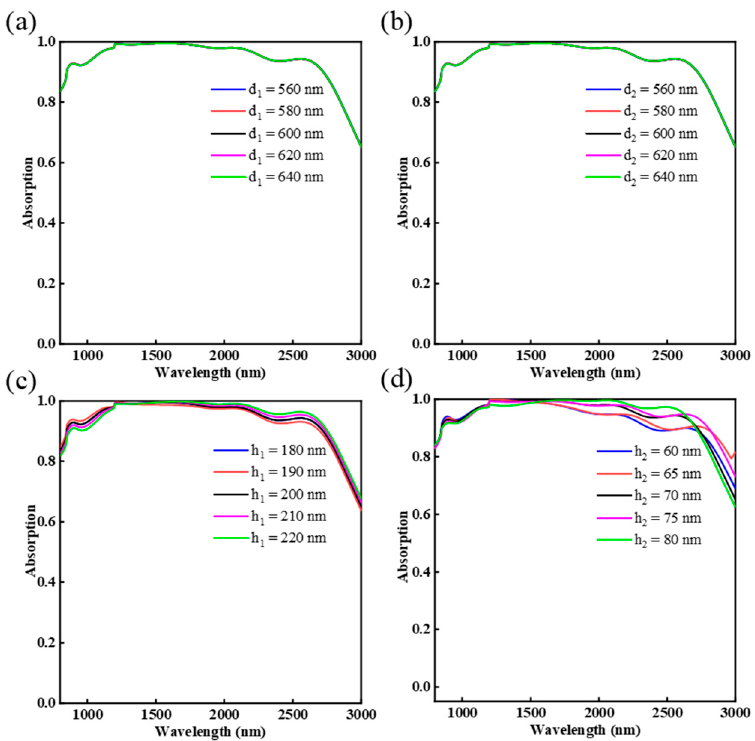
Figure 6. The influence of different structural parameters on the absorption properties: ( a ) distance between ring 1 and ring 2 d 1 ; ( b ) distance between ring 1 and ring 3 d 2 ; ( c ) thickness of the Cr nano- rings h 1 ; ( d ) thickness of Al 2 O 3 h 2 .